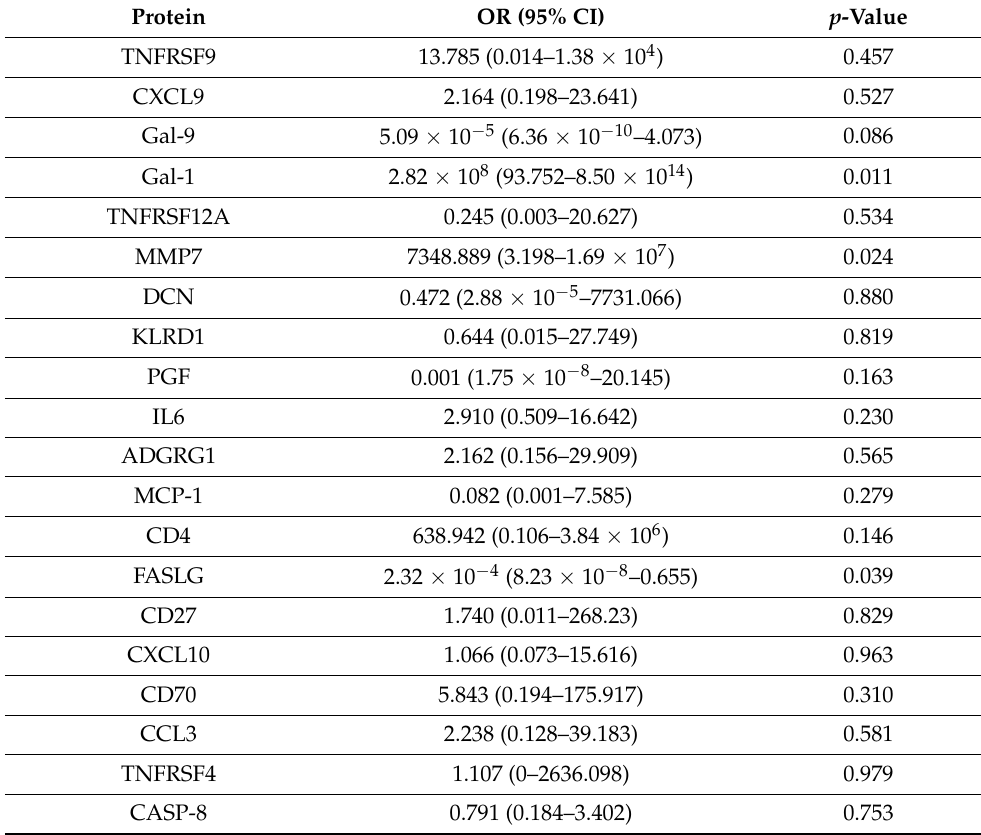
Table 2. Multivariate logistic regression model including all variables from the immune-oncology panel with p < 0.01 at binary logistic regression.